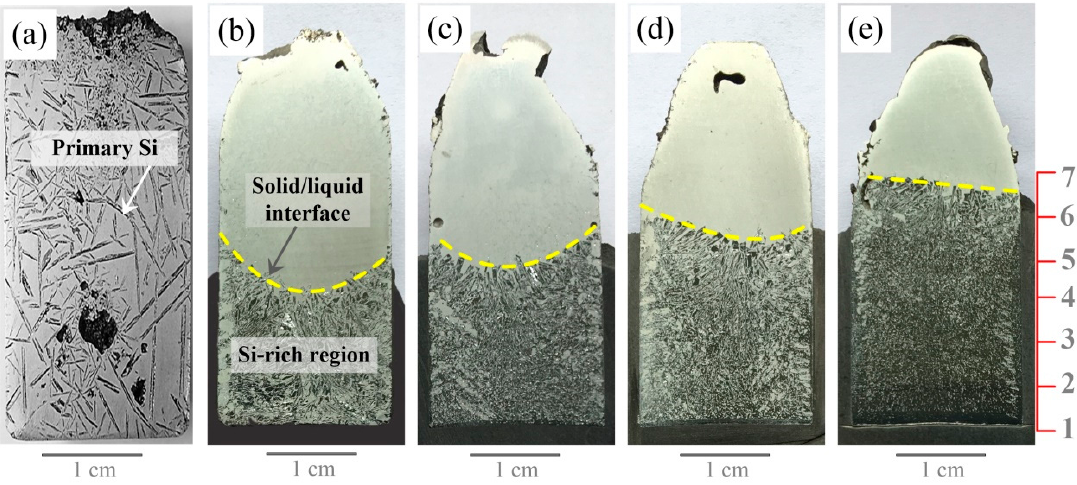
Figure 2. Cross-sections of the solidified samples: ( a ) Al-35 wt.% Si without EMDS, ( b ) Al-35 wt.% Figure 2. Cross ‐ sections of the solidified samples: ( a ) Al ‐ 35 wt.% Si without EMDS, ( b ) Al ‐ 35 wt.% Si Si with EMDS, ( c ) Al-45 wt.% Si with EMDS, ( d ) Al-55 wt.% Si with EMDS, and ( e ) Al-65 wt.% Si with EMDS, ( c ) Al ‐ 45 wt.% Si with EMDS, ( d ) Al ‐ 55 wt.% Si with EMDS, and ( e ) Al ‐ 65 wt.% Si with with EMDS.